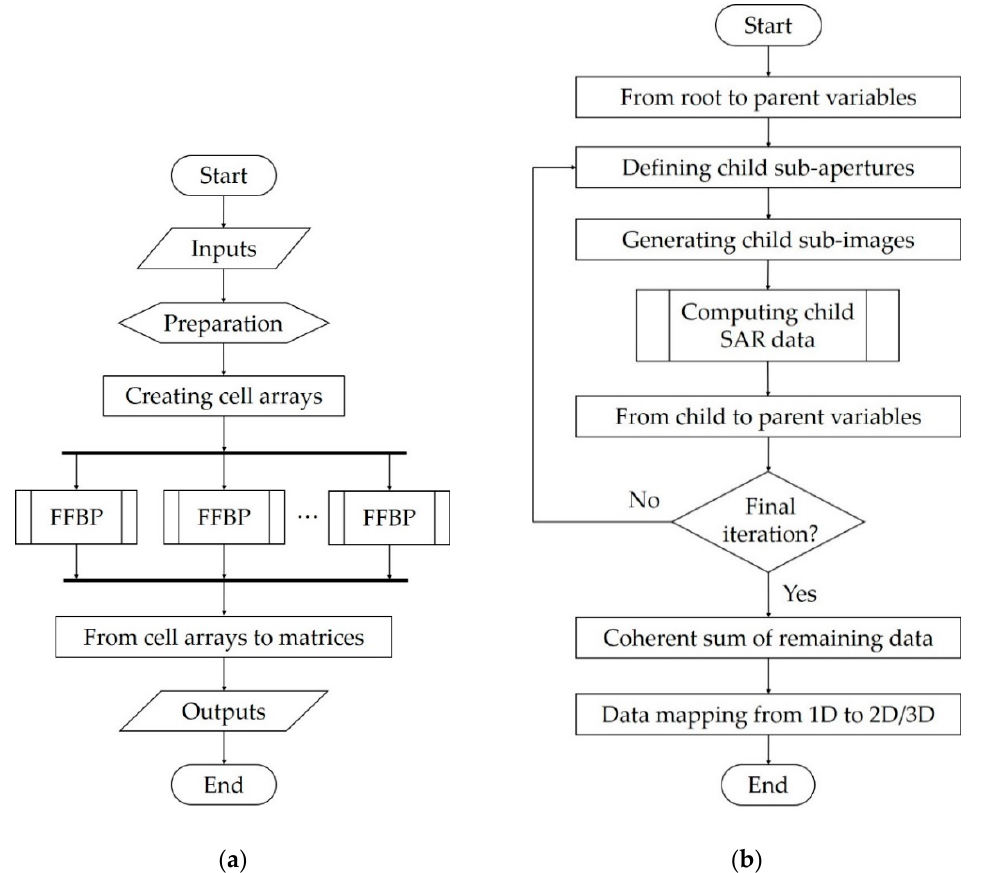
Figure 1. Flowchart of the algorithm: ( a ) parallel processing and ( b ) fast factorized back-projection (FFBP), an iterative process.